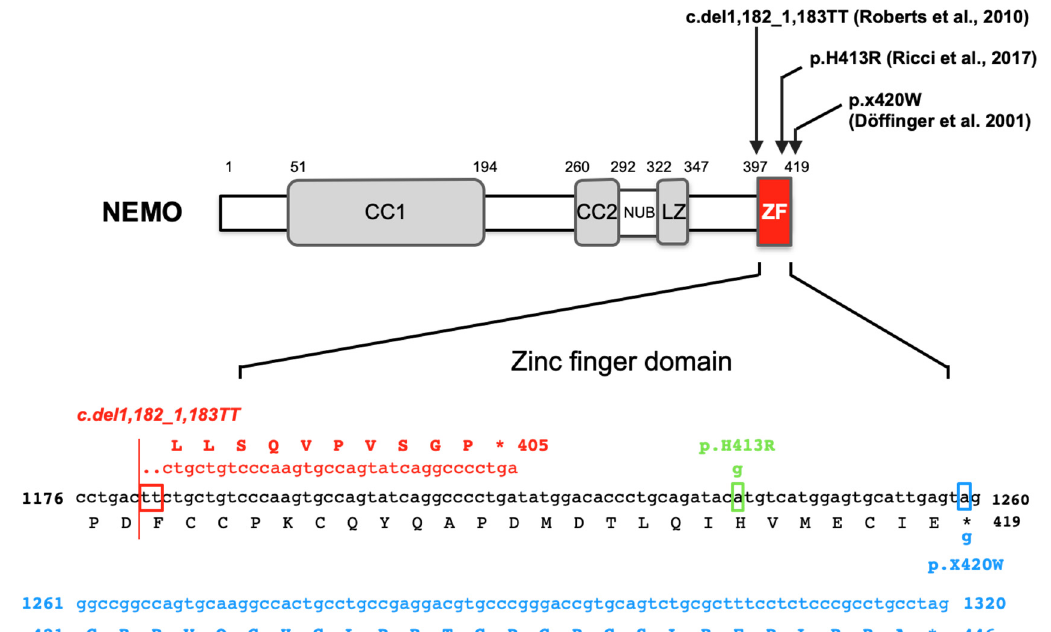
Figure 3. Schematic structure of NEMO and the genetic mutations in the IKBKG gene associated with osteopetrosis. The nucleotide and amino acid sequences of the IKBKG gene and the NEMO protein, respectively, are indicated in black (normal), blue (c.1,259A > G; p.X420W) [50], red (c.1,182_1,183del_insTT; OL-EDA-ID) [51], and green (c.1,238A > G; p.H413R) [52]. Dots indicate deletions, and open boxes indicate “stop codons”. CC: coiled-coil domain; NUB: NEMO ubiquitin binding; LZ: leucine zipper; ZF: zinc finger.